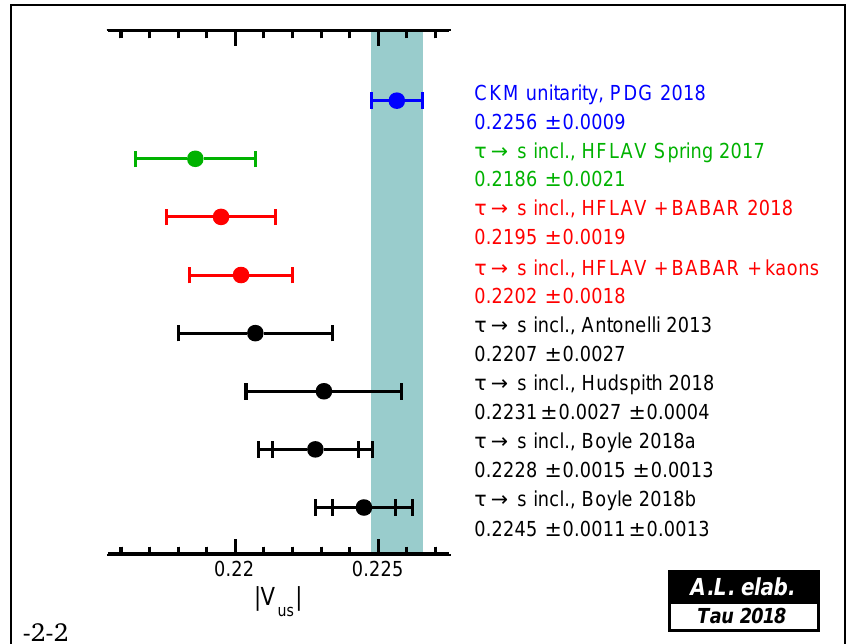
| Figure 1: | V τ s determinations obtained in this document, from the top: us | V | τ s with the HFLAV Spring 2017 fit, after adding the B A B AR 2018 data, after adding us both the B A B AR 2018 and the kaon indirect predictions, from Ref. [ 6 ] , from Ref. [ 21 ] , and two determinations from Ref. [ 22 ] .